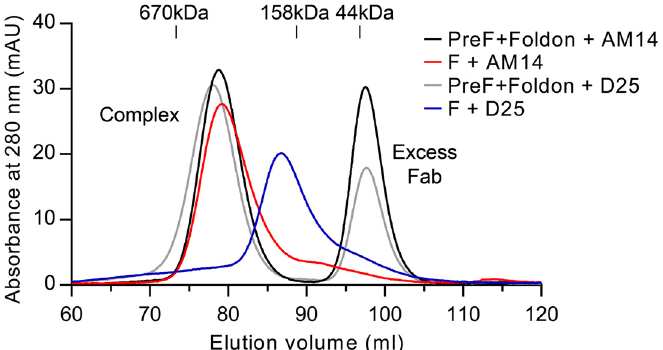
Fig 5. AM14 stabilizes RSV F trimer in the absence of the foldon trimerization motif. Size-exclusion chromatography profiles from a Superose 6 column are shown for AM14 Fab or D25 Fab complexed with prefusion RSV F containing the foldon trimerization motif (black and grey, respectively) and for AM14 Fab or D25 Fab co-expressed with RSV F ectodomain without foldon (red and blue, respectively).